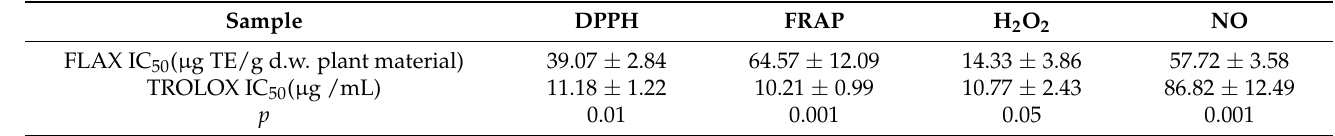
Table 2. Flaxseed ethanol extracts antioxidant activity